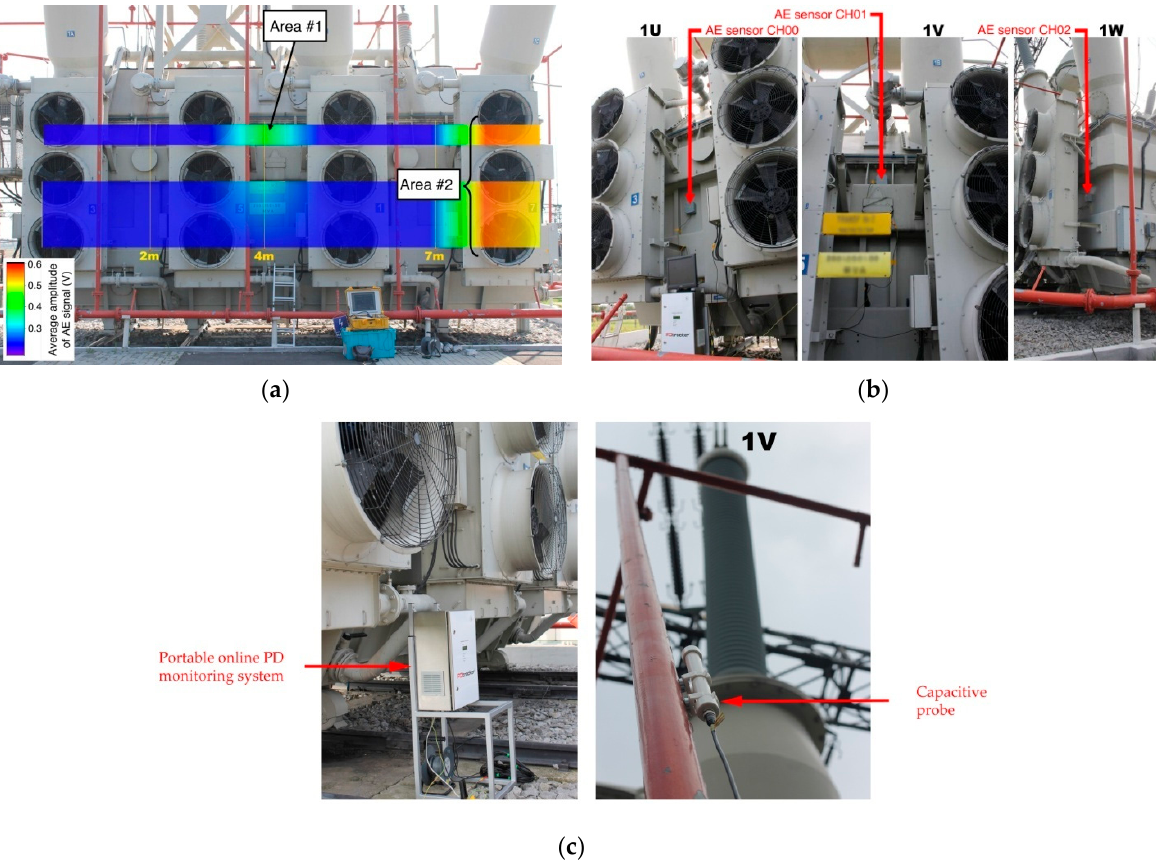
Figure 15. The tested 250 MVA power transformer: ( a ) The result of PD localization using a standard auscultatory technique (SAT), ( b ) arrangement of AE sensors on the transformer tank selected based on the obtained PD location results using the SAT method, and ( c ) photo of the portable PD monitoring system installed on the tested transformer and the place of mounting the capacitive probe for non-contact high voltage measurement.